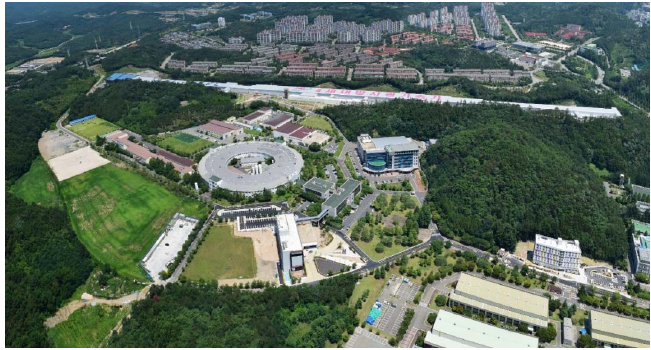
Figure 1. Overview of Pohang Accelerator Laboratory. The Pohang Light Source (PLS) is shown in the middle (circular building) and PAL ‐ XFEL is shown above the PLS.